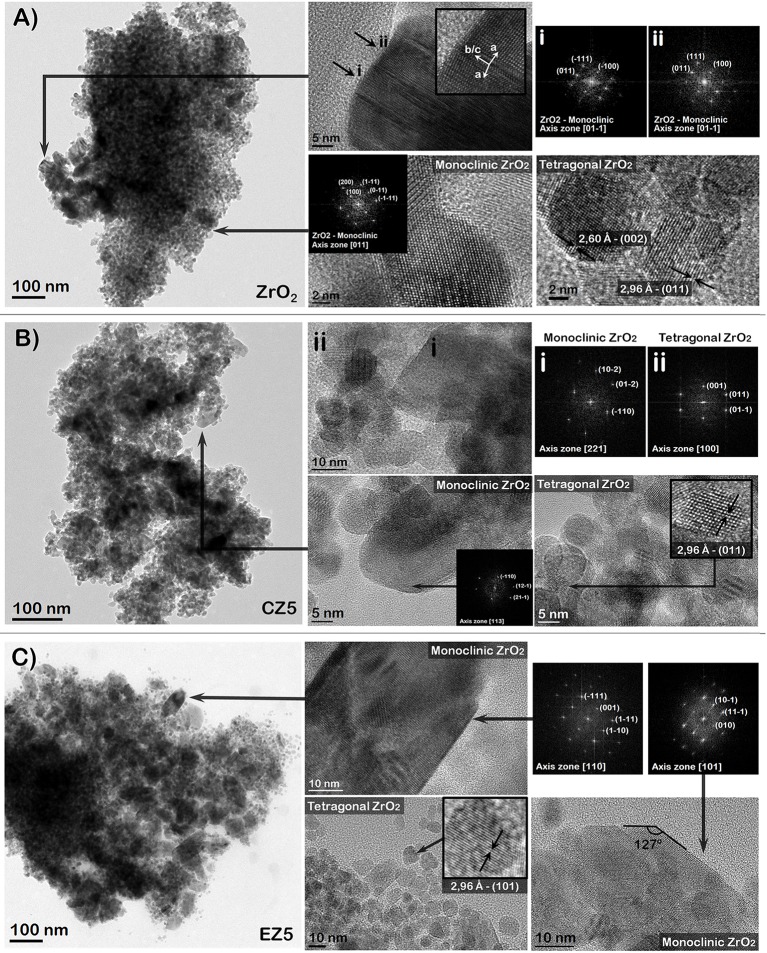
TEM (left column) and HR-TEM (center and right columns) images of pure ZrO2
(A) and RE-doped samples with 5 mol % of Ce and Er: CZ5 (B) and EZ5 (C), respectively.